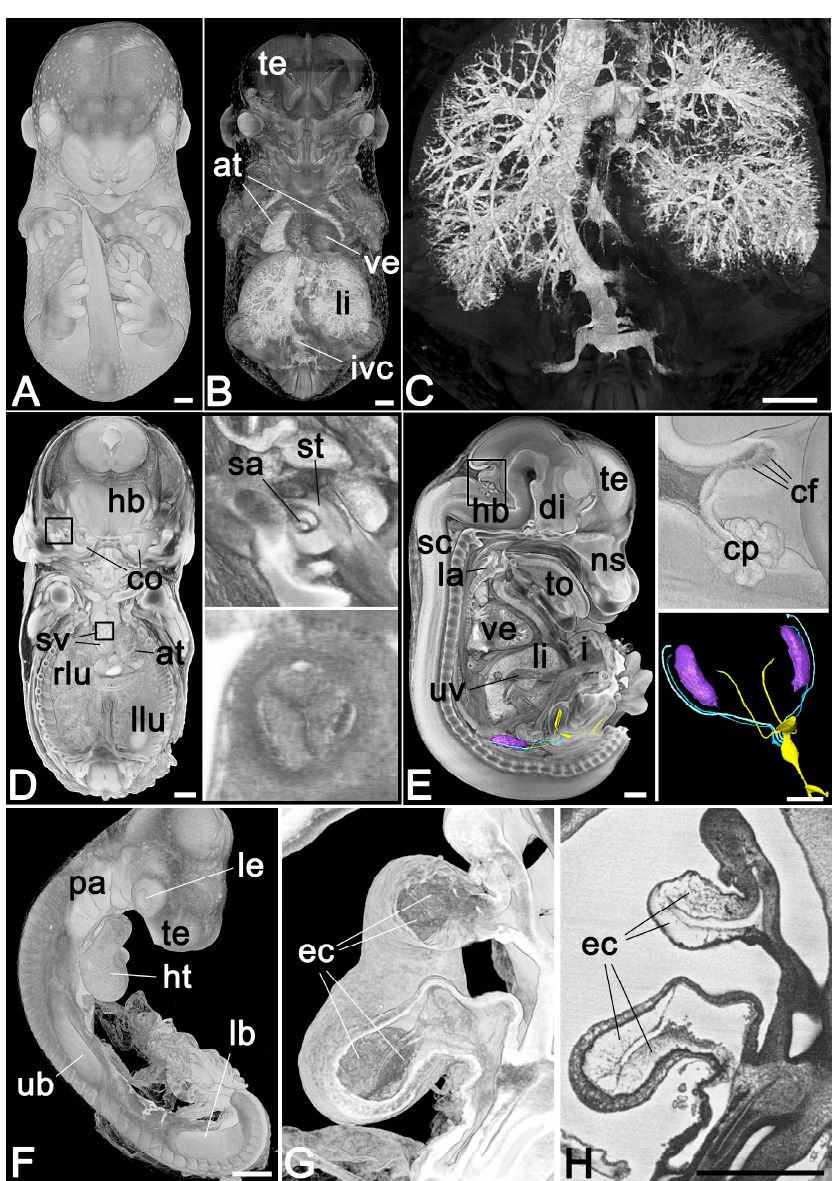
Figure 2. 3D visualisation of embryo material. ( A – E ) . Embryos harvested at embryonic day 14.5 in the scope of the Deciphering the Mechanisms of Developmental Disorders (DMDD) project. Opaque and semitransparent volume models from ventral view ( A – D ). Note the intrinsic contrast of the blood-filled liver vasculature inferior vena cava (ivc) and the atria (at) in ( B ) and ( C ). In ( D ), the opaque volume model is coronally sectioned and the stapedial artery (sa) penetrating the developing stapes (st) is zoomed in on in the inlay to the top. The bottom inlay provides the aortic valve as detailed as it appears in the coronal 2D resection used as a sectioning plane. ( E) shows a sagittally sectioned semitransparent volume model from lateral, integrating surface models of the urogenital tract. Choroid plexus (cp) and commissural fibres (cf) are detailed in the zoom-in displayed as an inlay to the top right. The bottom inlay shows a cranial and oblique view of the surface models of the ovaries (violet), ureter, urinary bladder and urethra (yellow), Müller duct (light blue) and Wolff duct (blue). ( F – H ). Chick embryo at developmental stage 18 according to Hamburger and Hamilton. Opaque volume model from the ventrolateral in ( F ) and ( G ) with a zoom-in on the virtually sectioned heart tube (ht) in ( G ). ( H ) shows the virtual 2D resection of the cutting plane in ( G ). ve, ventricles; li, liver; hb, hindbrain; co, cochlea; sv, semilunar valves; rlu, right lung; llu, left lung; te, telencephalon; di, diencephalon; sc, spinal chord; ns, nasal septum; to, tongue; la, larynx; uv, umbilical vein; I, intestine; pa, pharyngeal arches; le, lens; ub, bud of upper limb; lb, bud of lower limb; ec, endocardial cushion. Scale bars: 500 µm.